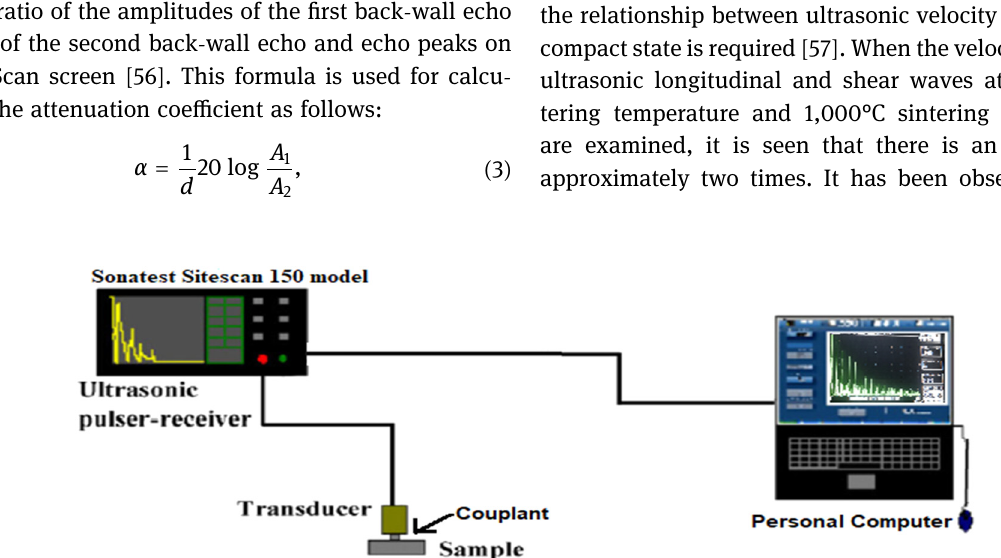
Figure 1: Ultrasonic pulse - echo testing